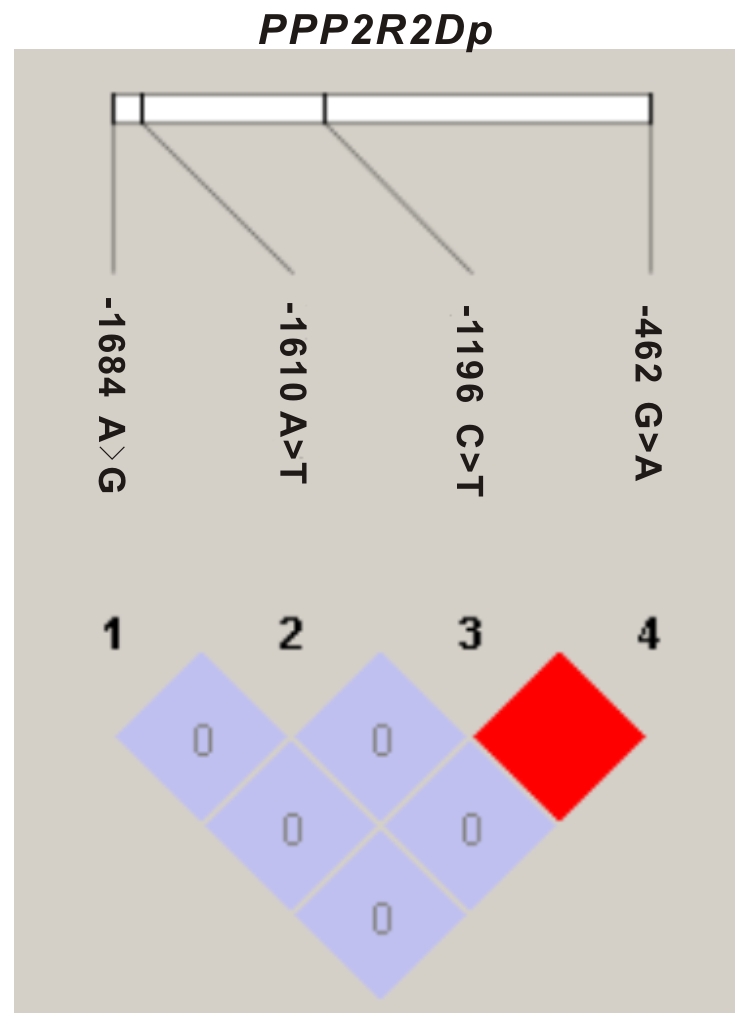
The LD structure of genetic variations in the 5′-flanking region of PPP2R2D.Pairwise linkage disequilibrium (LD) values between variants were calculated using Haploview in current Han Chinese population. The relative locations of variants are indicated along the top. The value within each diamond represents the pairwise correlation between variant sites (measured as r2) defined by the upper left and the upper right sides of the diamond. The diamond without a number corresponds to D′ = 1. Red diamonds indicate statistically significant allelic association between the pairs of variations, as measured by D′; Blue diamonds indicate pairwise D′ values of 1, but without statistical significance.